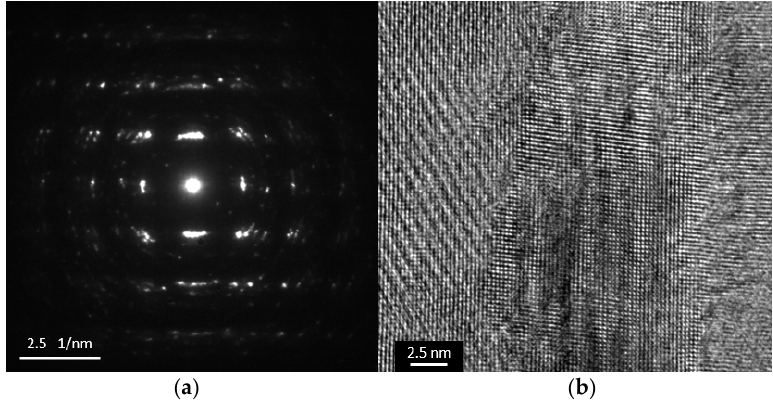
Figure 7. ( a ) Selected Area Electron Diffraction (SAED) pattern; and ( b ) High Resolution Transmission Electron Microscopy (HRTEM) observation between the boundaries of the Bi 2 Te 3 sample.